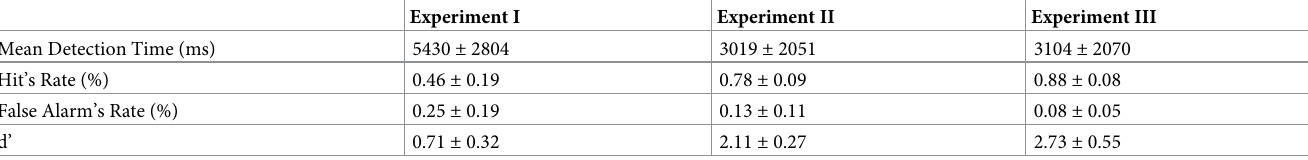
Table 3. Behavioral results for detection time and performance in the three experiments.